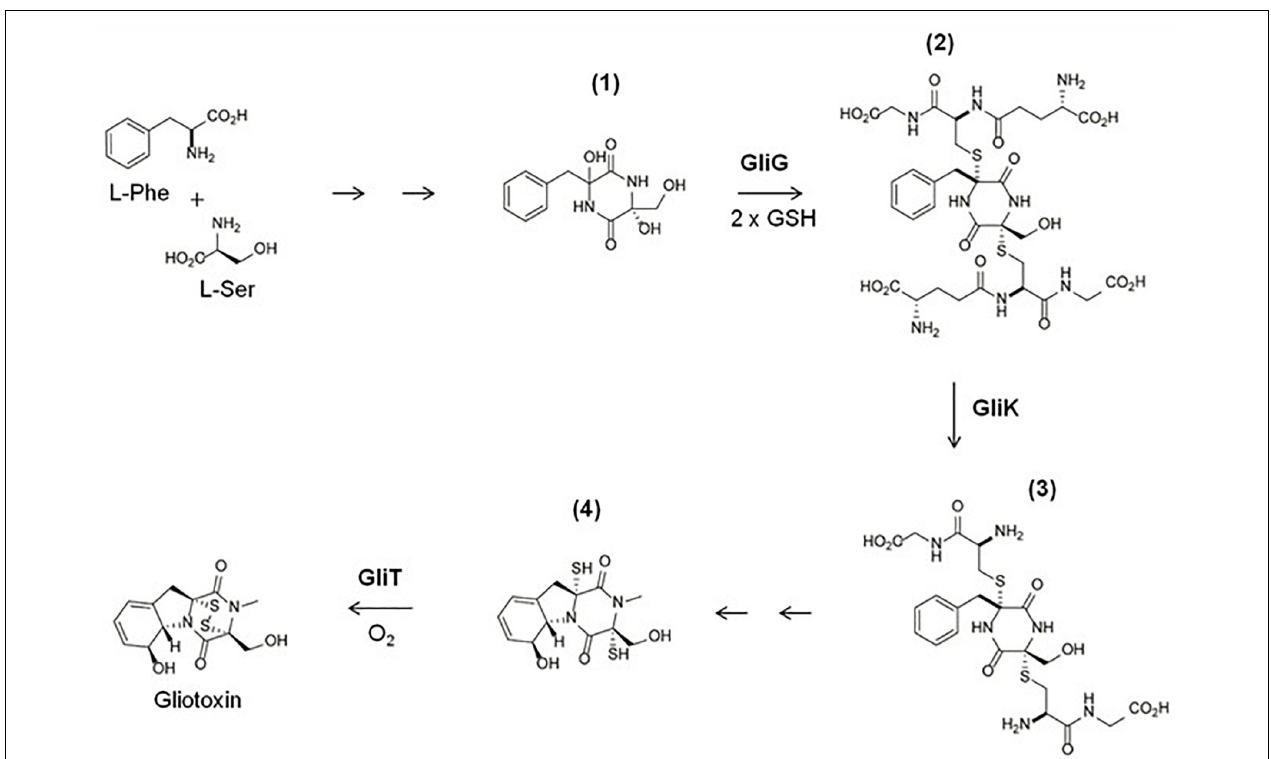
FIGURE 3 | An abridged schematic of the gliotoxin biosynthetic pathway, demonstrating GliG, GliK, and GliT activity. L-Phe and L-Ser are processed by GliP and GliC to form intermediate (1) . (1) Is then doubly thiolated using 2 GSH molecules by GliG, to form a sulphurised intermediate (2) . (2) Then undergoes bis -glutamyl elimination, catalyzed by GliK, to yield (3) . (3) Then undergoes several more enzymatic reactions to yield (4) . The final product, gliotoxin, is then formed from (4) by the closure of the disulfide bridge via GliT (Schrettl et al., 2010; Gallagher et al., 2012; Scharf et al.,